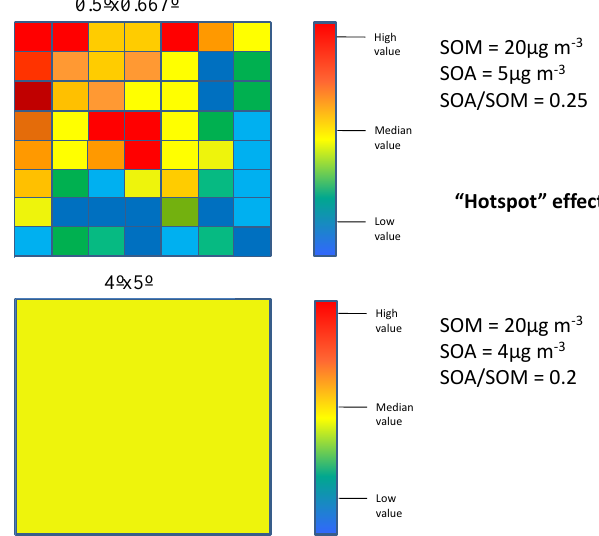
Fig. 11. A representation of the “hotspot” effect that affects the partitioning of SOM between resolutions in the model. Higher- resolution simulations will resolve variability in SOM and POA (POA not shown). In GEOS-Chem, resolving this variability leads to increases in SOA partitioning in regions of high SOM (or POA), and decreases in SOA partitioning in regions of low SOM (or POA). The regions with SOA partitioning decreases do not fully compen- sate for the regions with increases because more SOM mass is con- tained in the hotspot